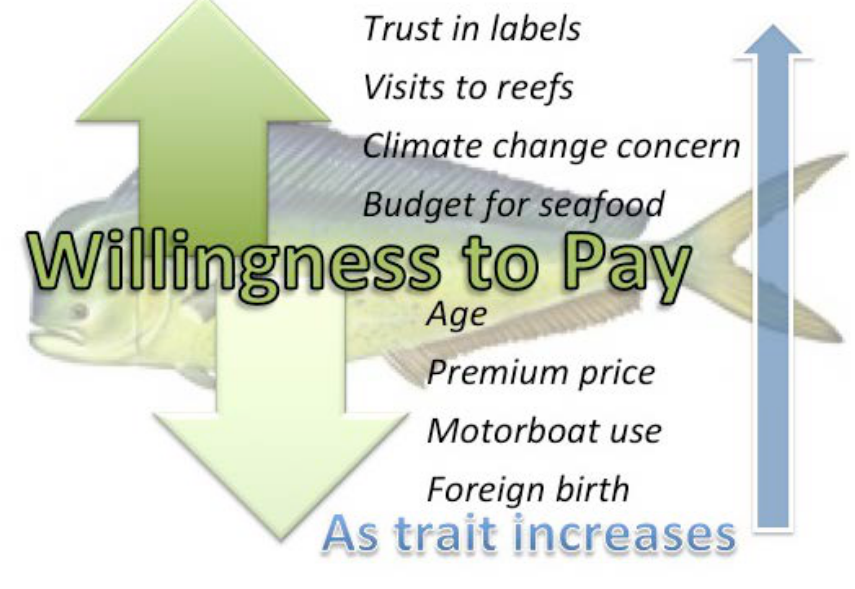
Figure 8. Summary of local seafood scenario’s significant traits (variables) and direction of influence on willingness to